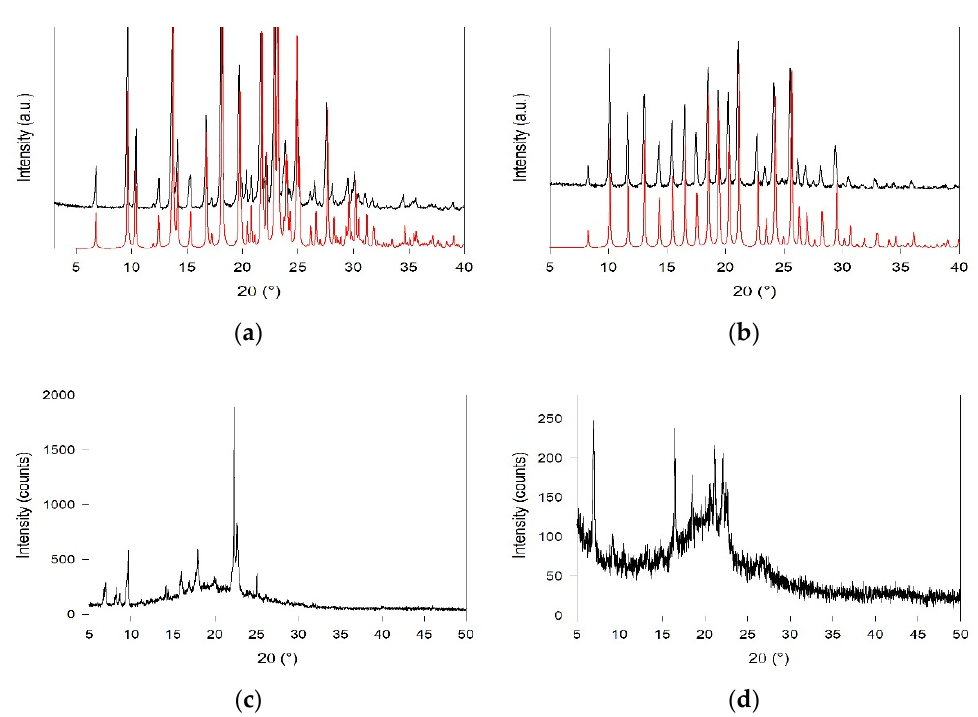
Figure 2. XRPD patterns of ( a ) Fura and ( b ) m -xy, ( c ) p -xy and ( d ) diphen samples. Black lines: experimental patterns, and red line: patterns predicted by the Mercury software [35] on the basis of single crystal data reported in the literature [36,37].